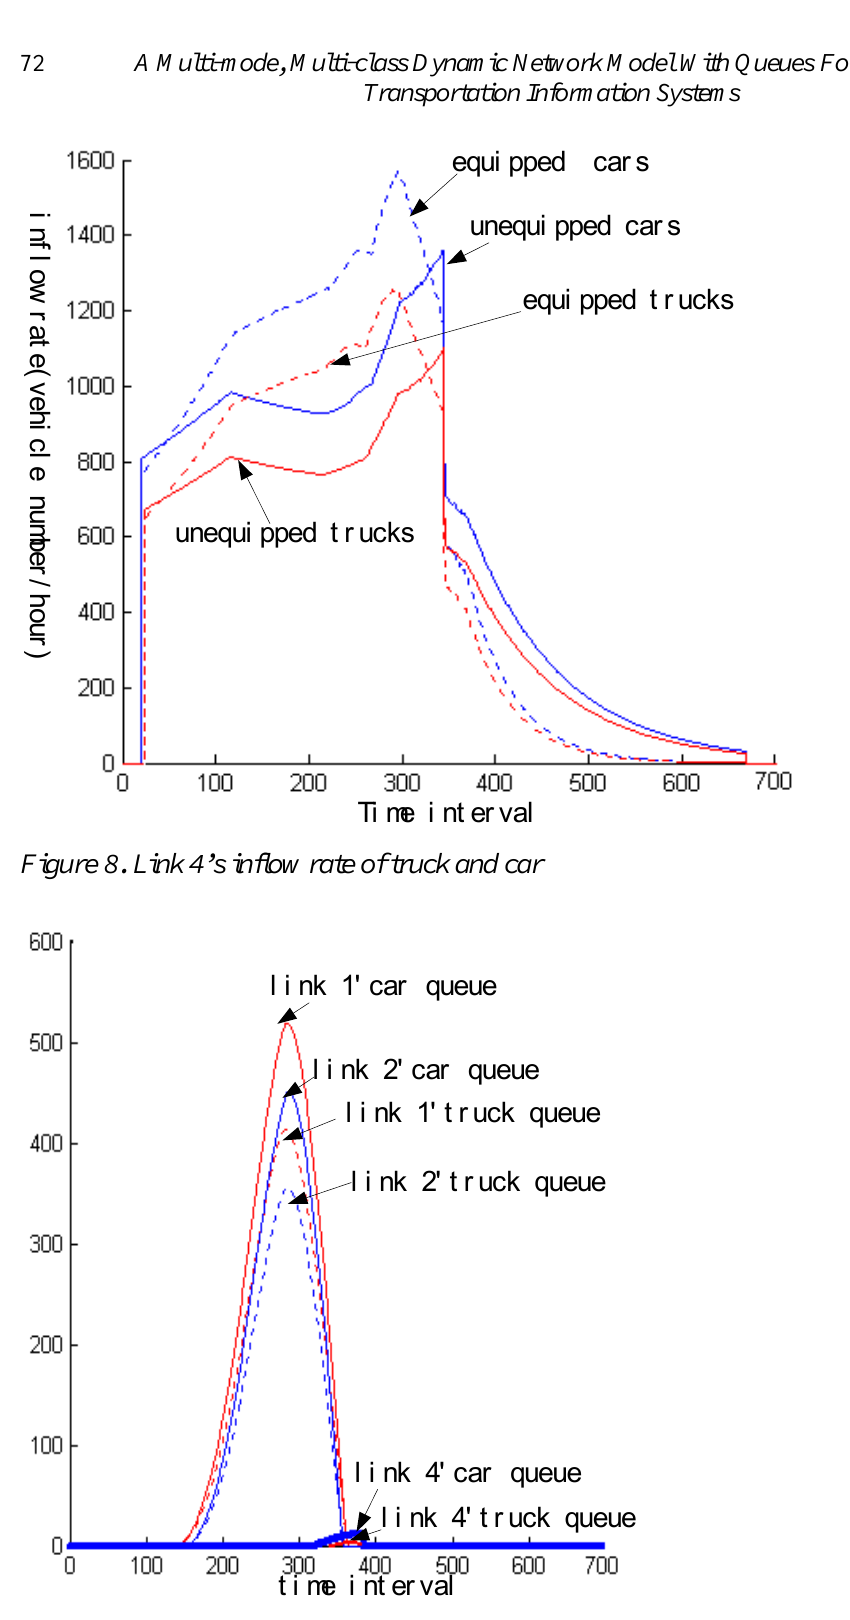
Figure 9. Link queue vehicle of truck and